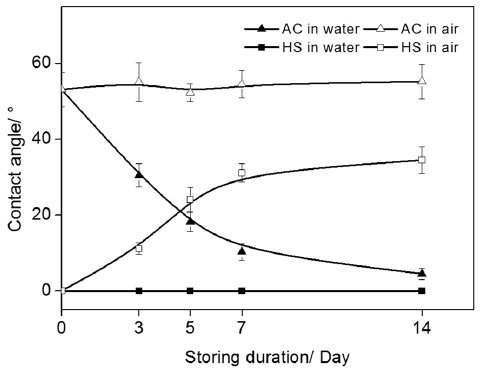
Figure 4. Changes of contact angle on specimens stored under different conditions.